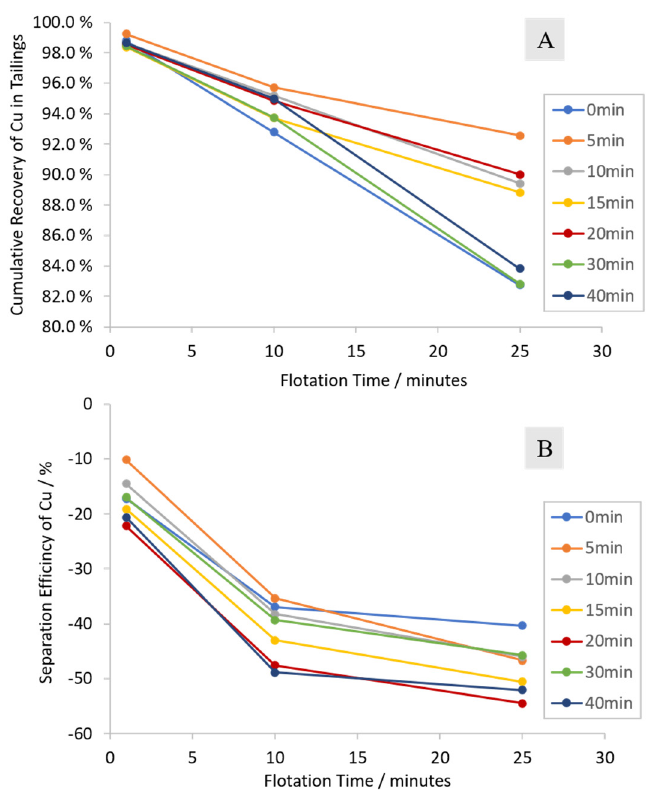
Figure 8. The ( A ) cumulative recovery in the tailings and the ( B ) separation e ffi ciency for Cu, after various milling times.